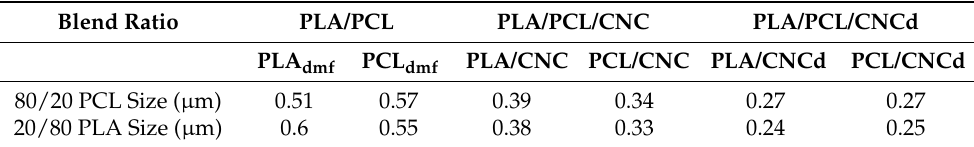
Table 1. Size of dispersed particles in PLA/PCL blends and nanocomposites with matrix/inclusions structure (PLA dmf and PCL dmf are components treated with dimethyl formamide analogously to masterbatch